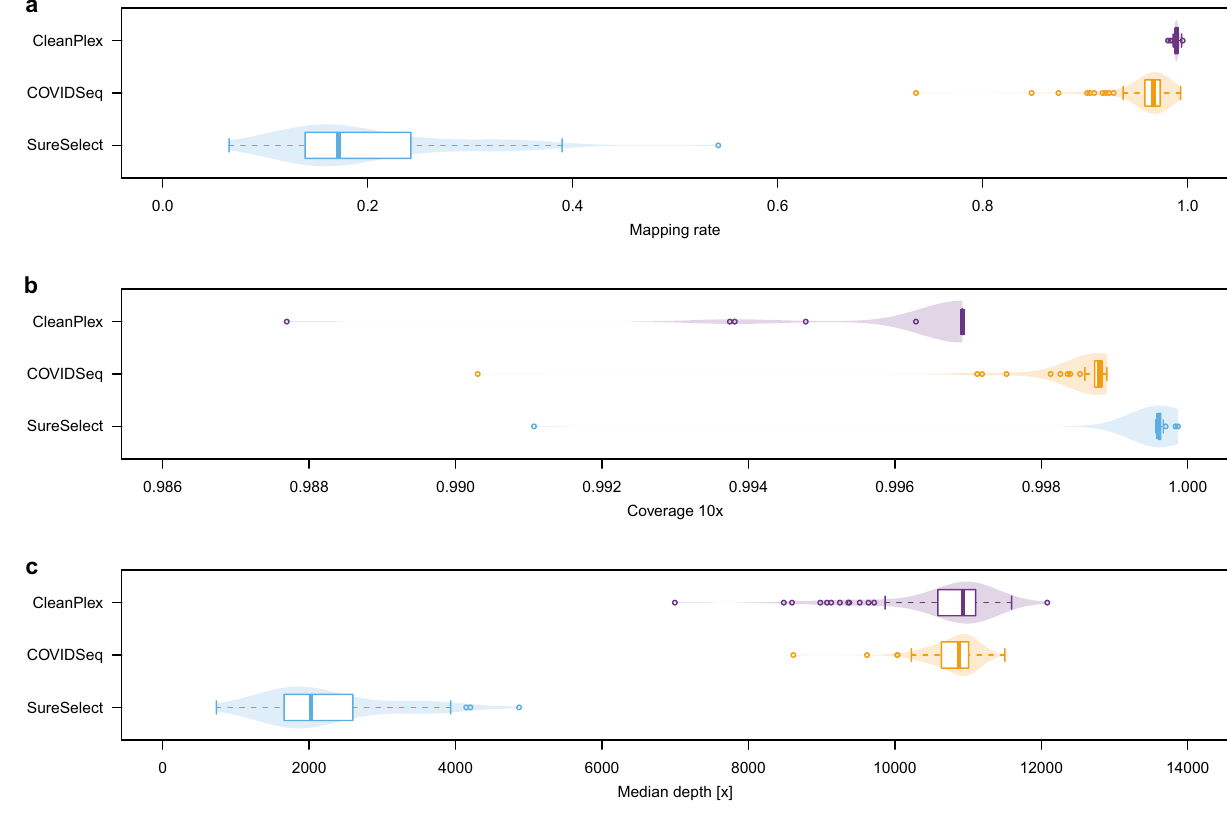
Figure 1. Comparison of target enrichment kits performance. ( a ) SARS-CoV-2-specific mapping rate. ( b ) Breadth of coverage of the SARS-CoV-2 genome, where the depth of coverage is at least 10× . ( c ) Median depth of